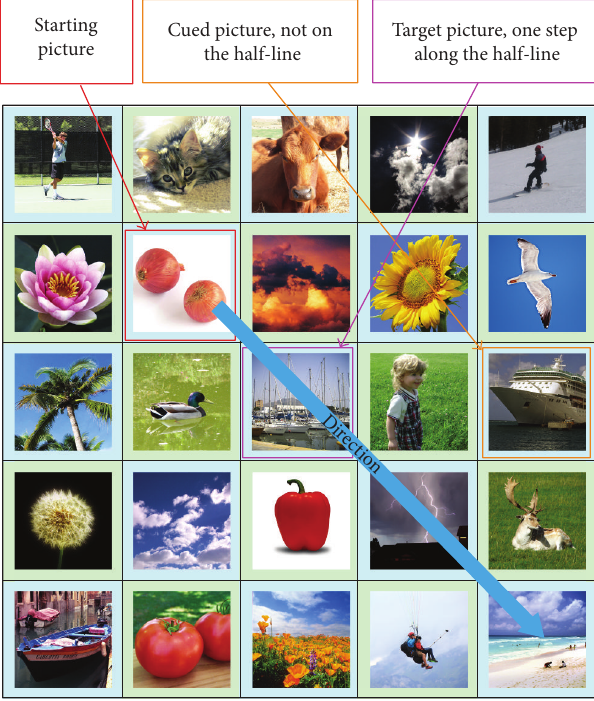
Figure 7: Scenario 1: cued picture is not on the half-line.